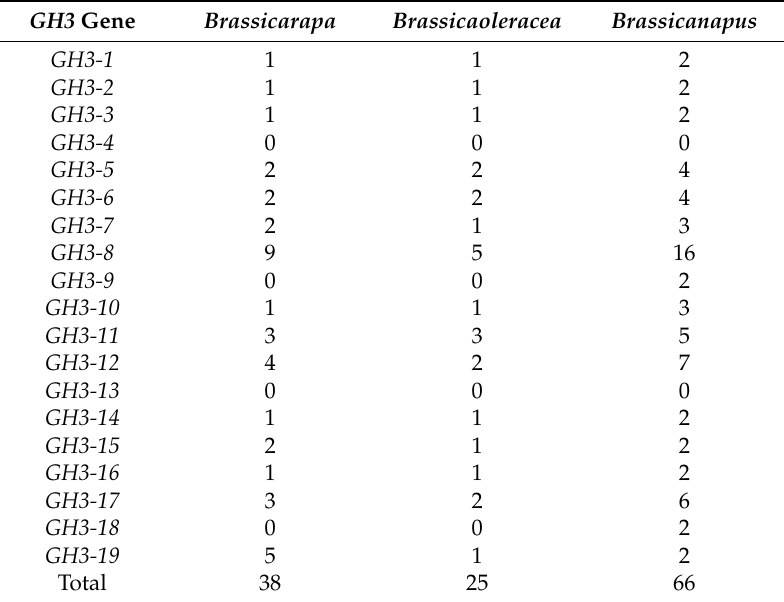
Table 1. The number of GH3 genes in the three species of Brassica . GH3